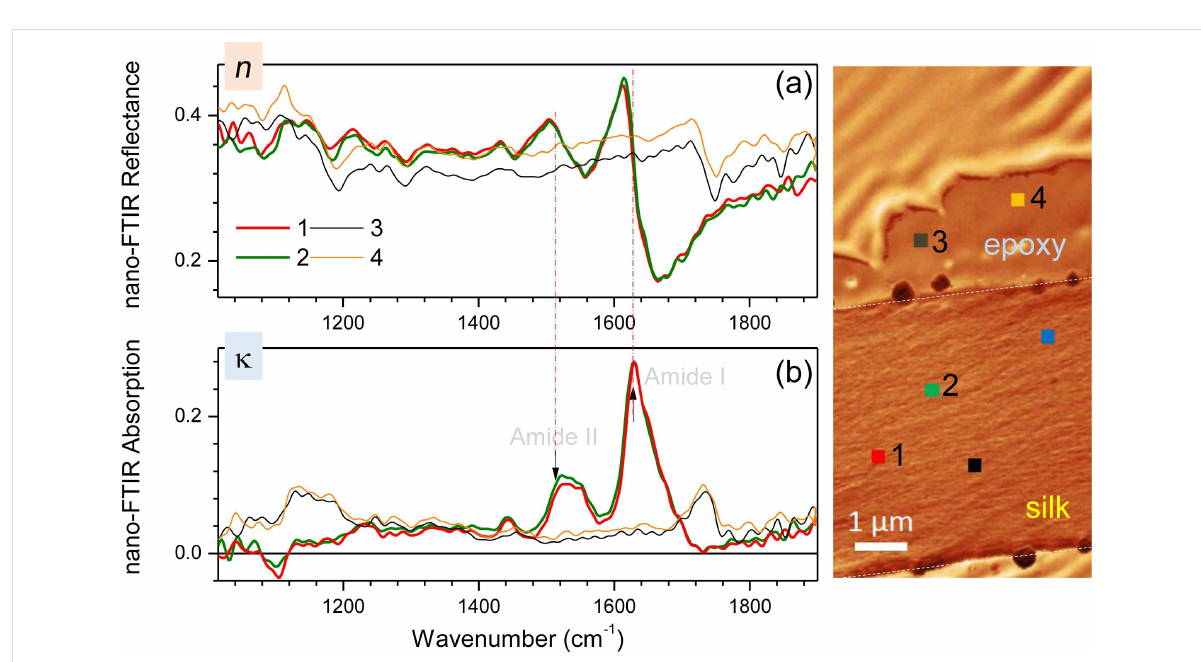
Figure 5: Scattering near-field optical microscopy (SNOM) measurements of the nano-FTIR reflectance (a) and absorption (b) spectra from selected points on silk and epoxy (shown in the right